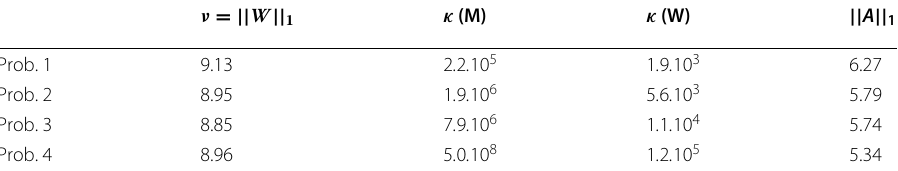
Table 2 Norms and 2-norm condition numbers of matrices for Problems 1–3, and 1-norm condition number of Problem 4 of Cylinder